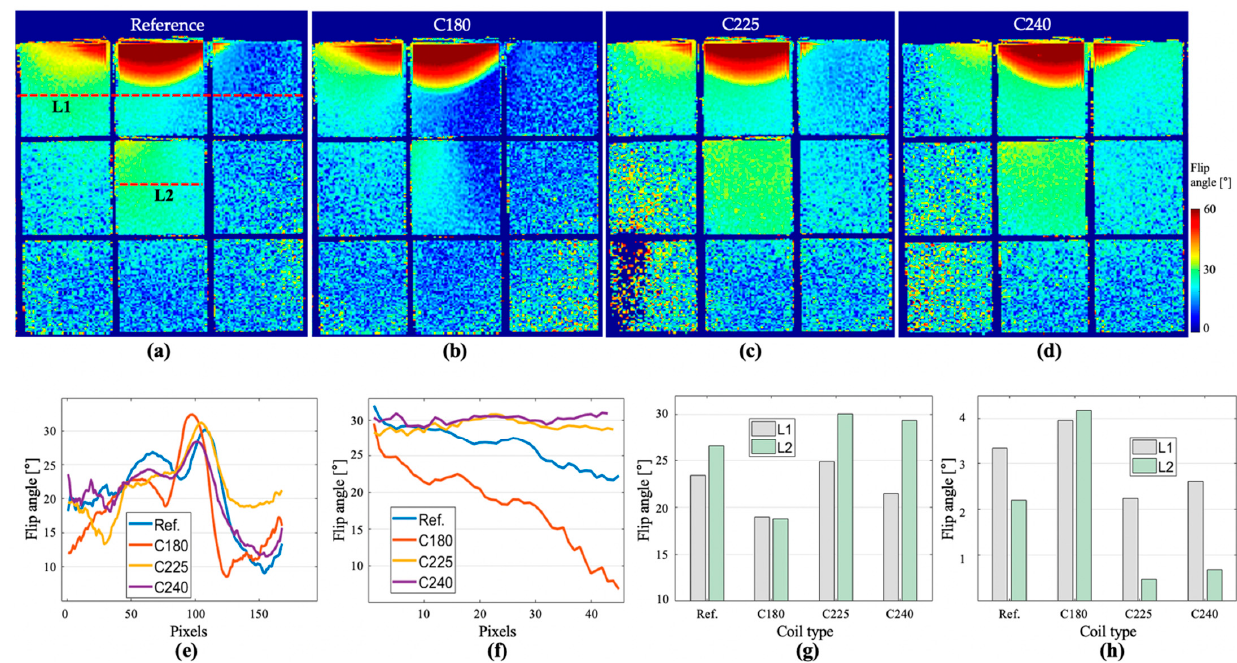
Figure 14. The computed flip angle maps for the ( a ) reference coil, ( b ) C180, ( c ) C225 and ( d ) C240 coils. The line profile for ( e ) L1 and ( f ) L2. The ( g ) mean value of the line profiles, and the ( h ) standard deviation for each line profile.